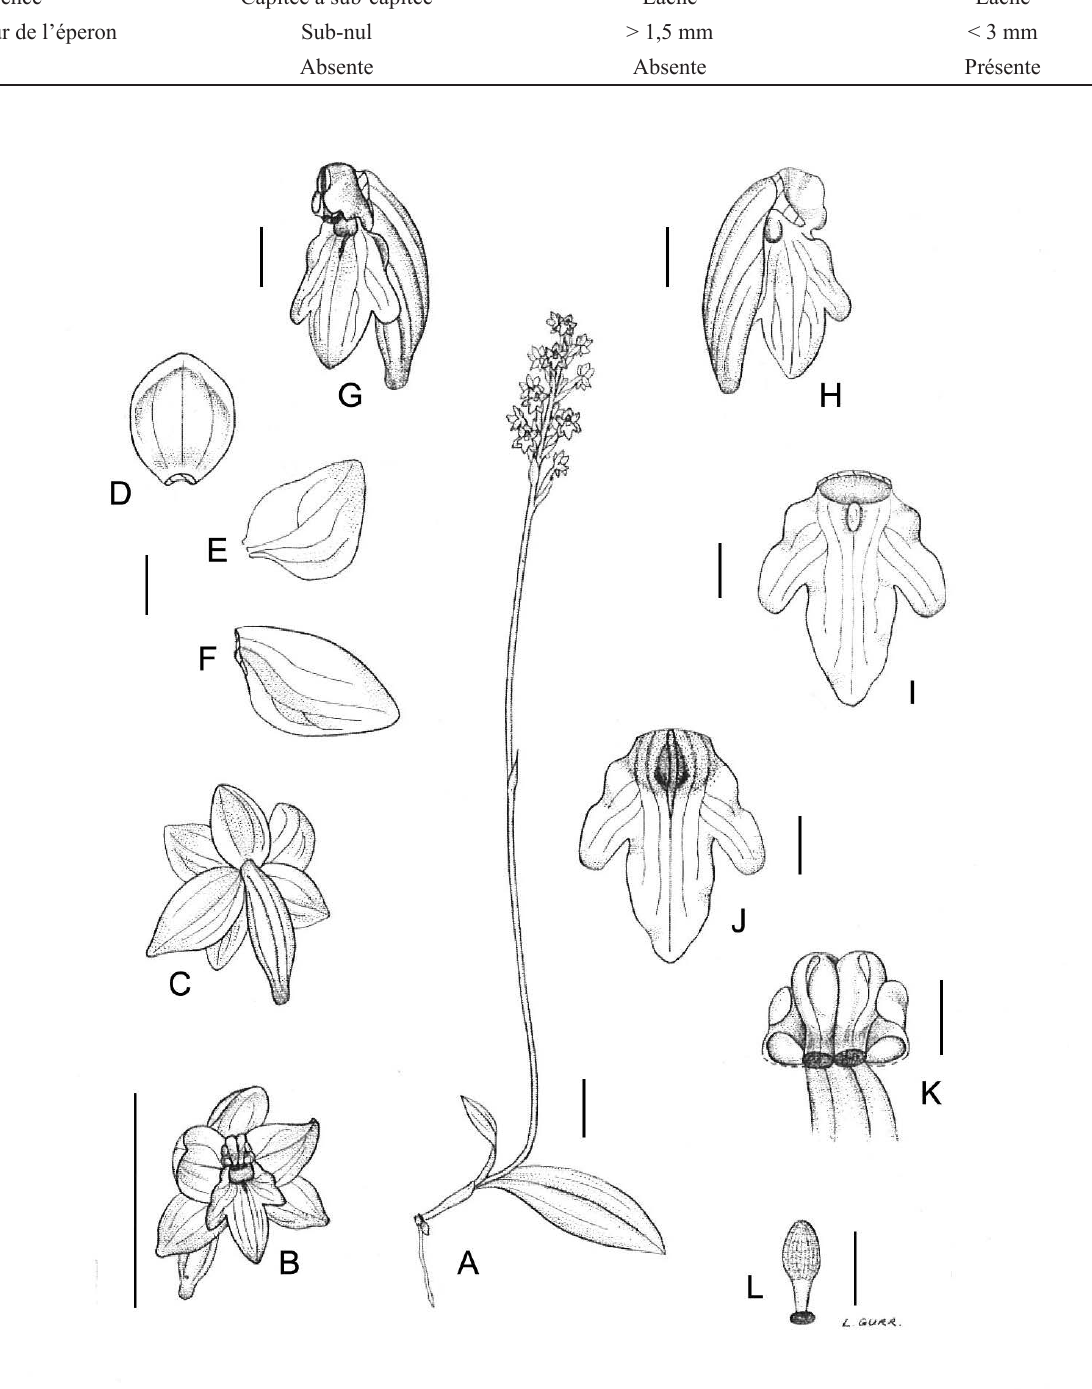
Figure 1 – Cynorkis borbonica . A . Plante entière. B . Fleur vue de face. C . Fleur vue de dos. D . Sépale dorsal. E . Pétale. F . Sépale latéral. G . Fleur sans les sépales et les pétales vue de face. H . Fleur sans les sépales et les pétales vue de dos. I . Labelle vu de face. J . Labelle vu de dos. K . Colonne vue de face. L . Pollinie. Dessins de Lynda Gurr. Echelles: A, B–C : 1 cm ; D–L : 1